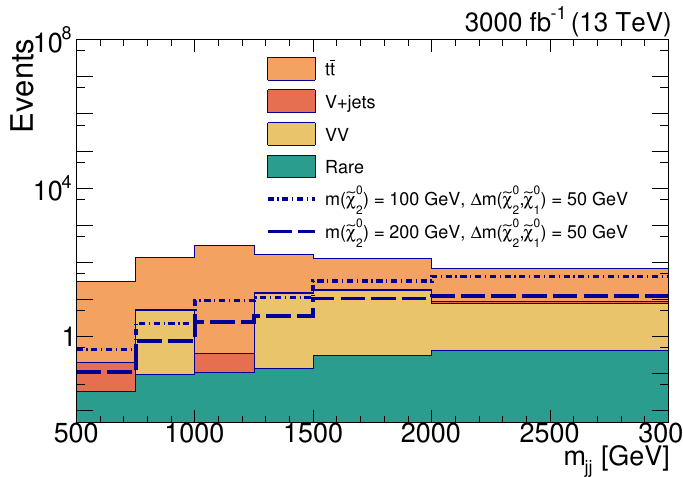
Figure 9 . The m jj distribution in the di-lepton signal